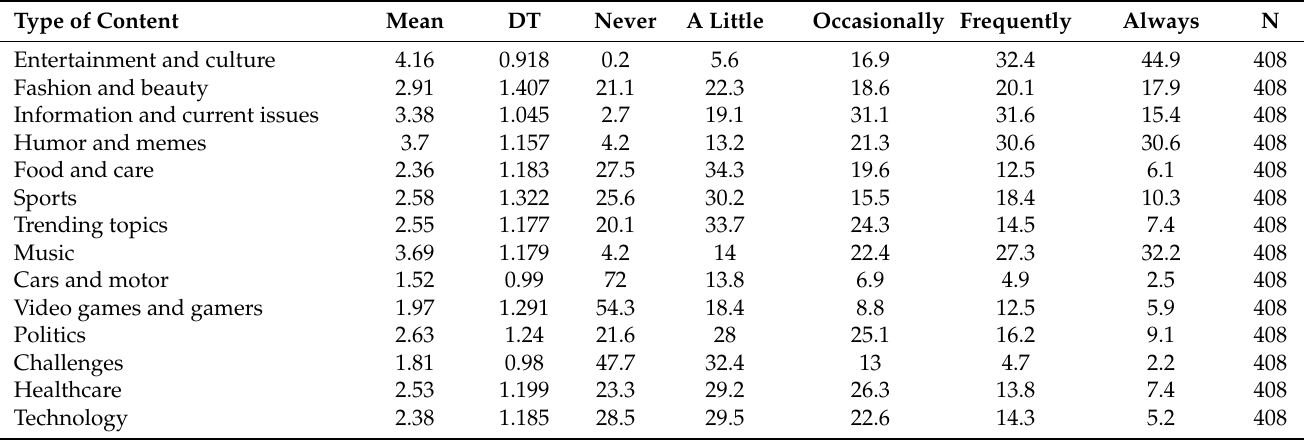
Table 6. Basic statistics for variable (V 8 ): Social media content consumption since COVID-19 occurred. Own elaboration.